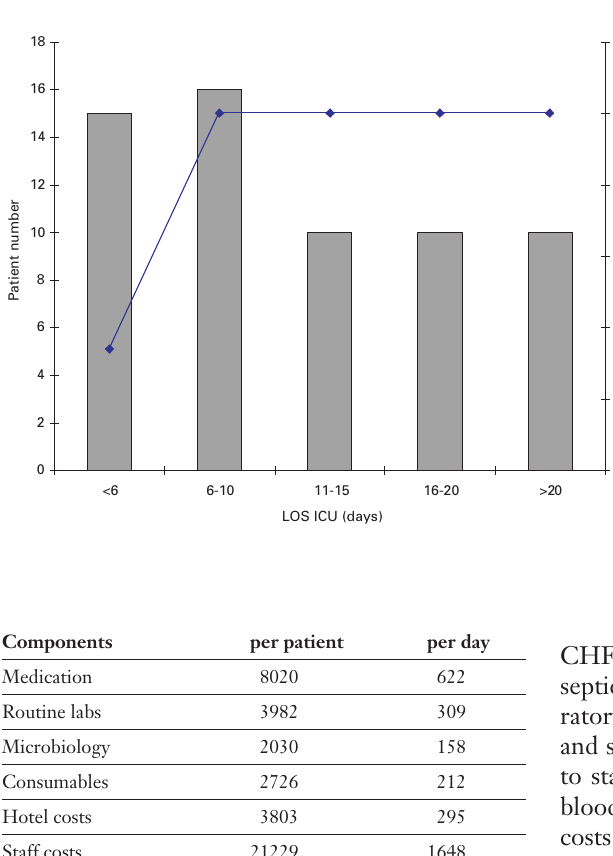
Distribution of length of stay of severely septic patients in ICU and percentage of non-survivors.